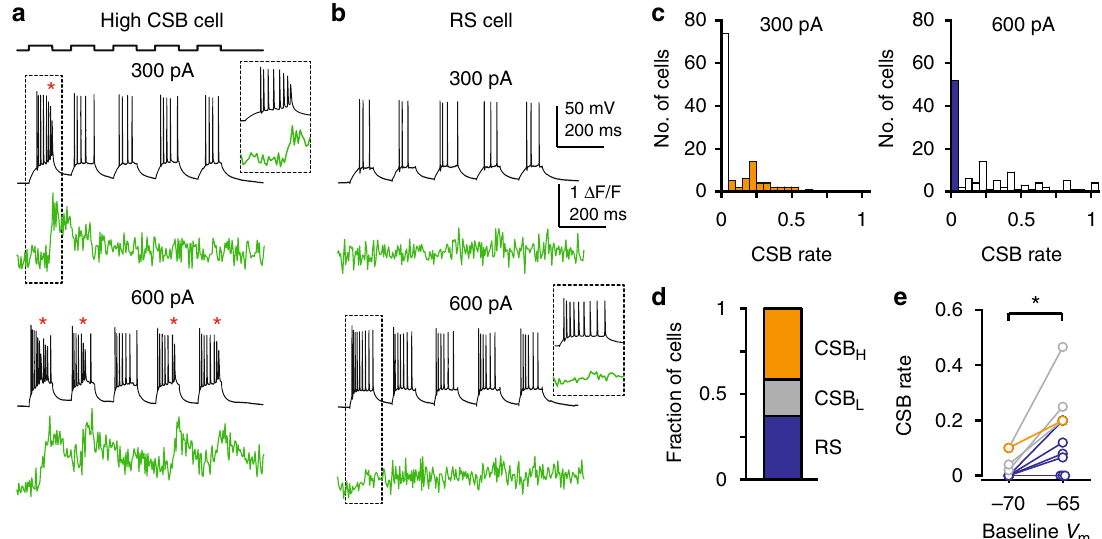
Fig. 2 Diversity of CSB propensity among CA3PCs. a Representative voltage and distal dendritic Ca 2 + responses of a high CSB cell to repetitive 100-ms somatic injection of 300 and 600 pA (protocol on top). Dashed box is shown enlarged in inset. CSBs are indicated by red asterisks. b Same as in a for a representative RS cell. Note the lack of CSBs at 600 pA I inj . c Histogram of CSB rate by 300 pA (left) and 600 pA (right) I inj . CSB H cells and RS cells are indicated in orange and blue, respectively. d Fraction of CSB H , CSB L , and RS cells in the whole recorded dataset. e Effect of V m on CSB rate by 600 pA I inj . Color code as in d . * p < 0.05. Source data are provided as a Source Data fi categories: cells with high CSB propensity (CSB H ; I inj threshold ≤ the large heterogeneity in CSB propensity, the properties of 300 pA), cells with low CSB propensity (CSB L ; I inj threshold the fi rst AP evoked by 600 pA I inj were similar across the 400 – 600 pA) and regular spiking cells (RS; I inj threshold > three CA3PC groups (Supplementary Fig. 2), with a slightly more negative AP threshold in CSB H cells (Supplementary Fig. 2g). 600 pA; Fig. 2d). Cells with different CSB rates were found in Although the range of fi rst AP onset time largely overlapped slices from the same animals (Supplementary Fig. 2a). Depolar- across the three CA3PC groups, it was signi fi cantly shorter in ization increased CSB rate in most cells (Fig. 2e, Wilcoxon test, CSB H cells (Supplementary Fig. 2h). p = 0.011, n = 11), including some, but not all RS cells. Despite